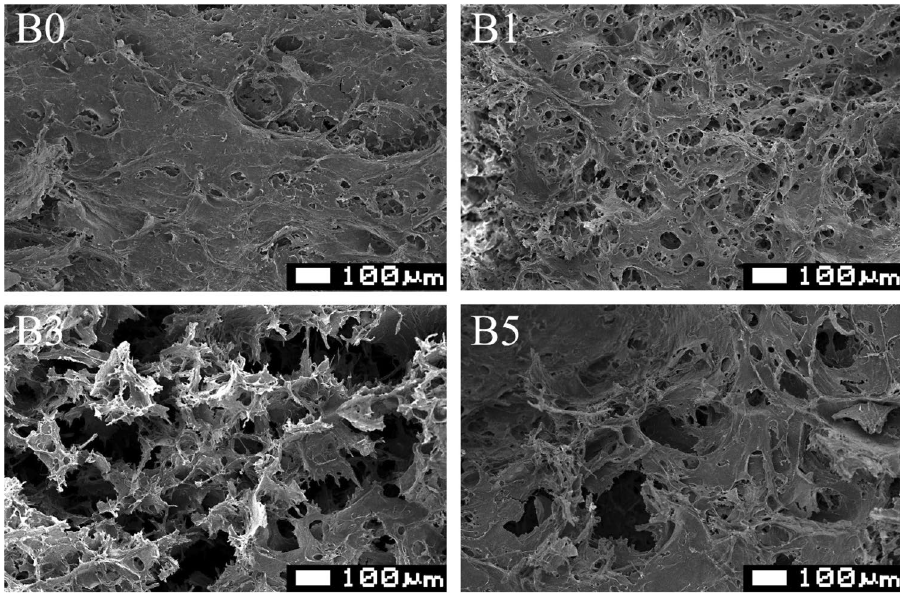
Figure 6. Scanning election microscopy (SEM) images of the cross-linked hydrogels with various concentrations of borax after